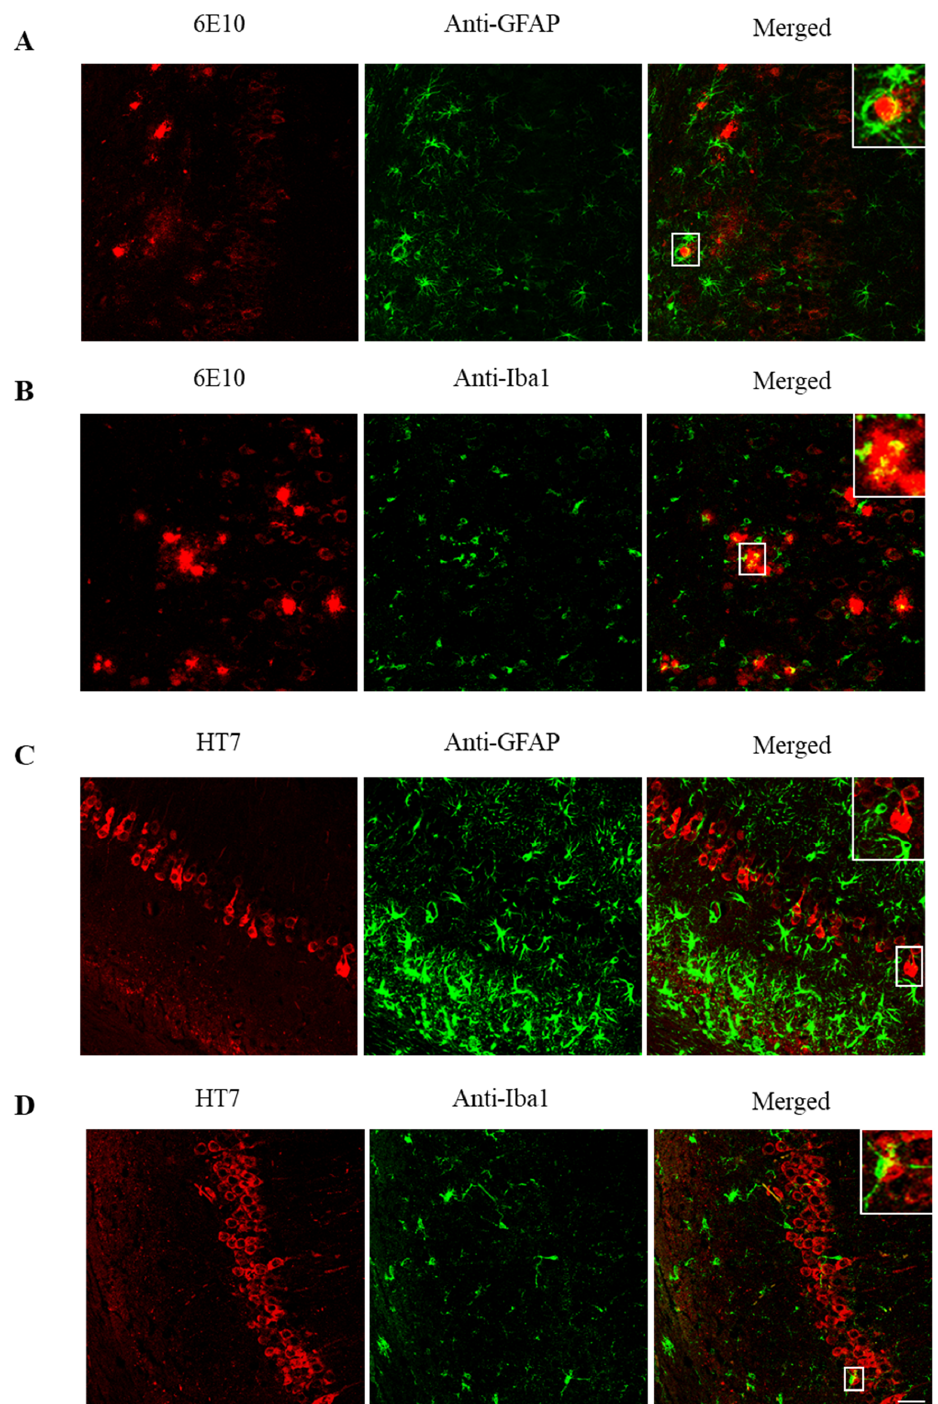
Figure 5. Astroglia and microglia surround Aβ-peptide and tau protein in the hippocampus. ( A ) Aβ and GFAP (astroglia) labeling in 3xTg-AD mice. Aβ in red (left), glial fibrillary acidic protein (GFAP) in green (center), and Aβ/GFAP merged (right). Astrocytes surround senile plaques. ( B ) Aβ and Iba1 (microglia) labeling in 3xTg-AD mice. Aβ in red (left), Iba1 in green (center), and Aβ/Iba1 merged (right). Microglia surrounds senile plaques. ( C ) Tau and GFAP labeling in 3xTg-AD mice. Tau in red (left), GFAP in green (center), and tau / GFAP merged (right). Astrocytes surround tau deposits. ( D ) Tau and Iba1 labeling in 3xTg-AD mice. Tau in red (left), Iba1 in green (center), and tau / GFAP merged (right). Microglia surrounds tau deposits. Scale bar, 25 µ